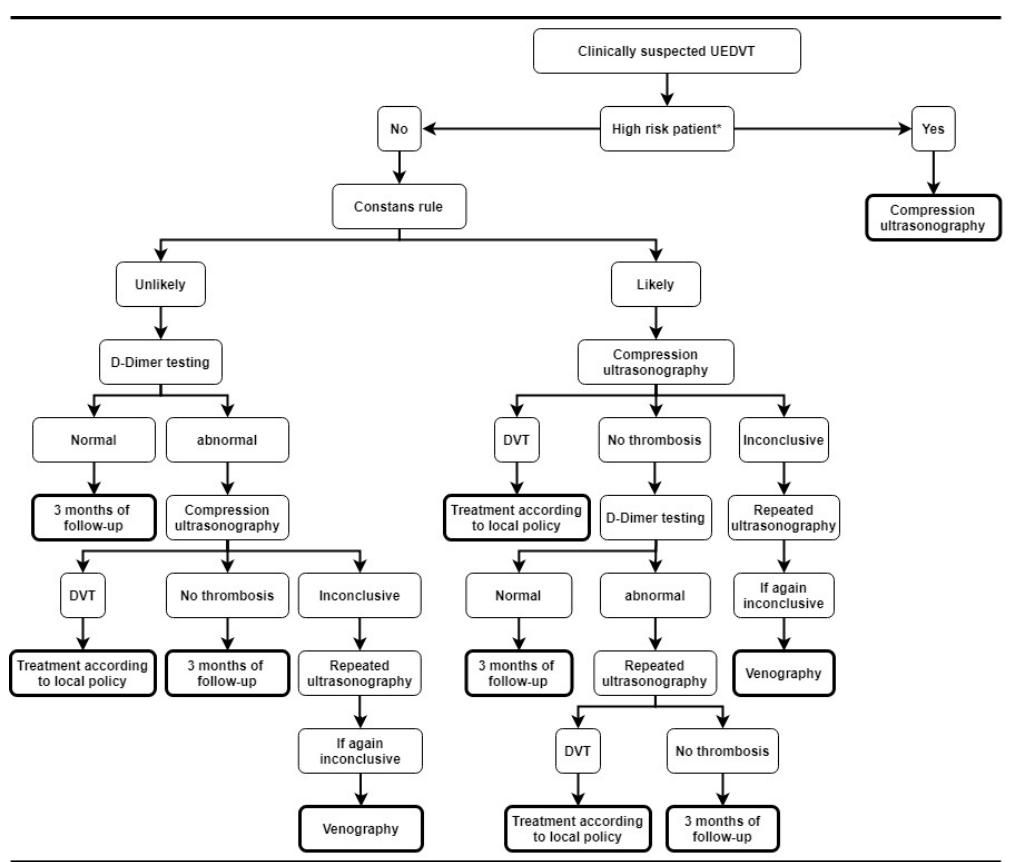
Figure 2. Diagnostic algorithm for upper extremity deep vein thrombosis based on the Armour study. * High risk patients: patients with malignancy, central venous catheter, or pacemaker, inpatients, or elderly ( ≥ 75 year old). Abbreviations: UEDVT, upper extremity deep vein thrombosis; DVT, deep vein thrombosis.